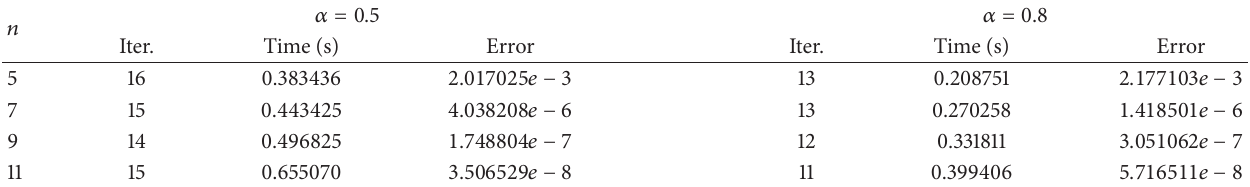
Table 2: The performance of spectral deferred correction method for solving Example 2.